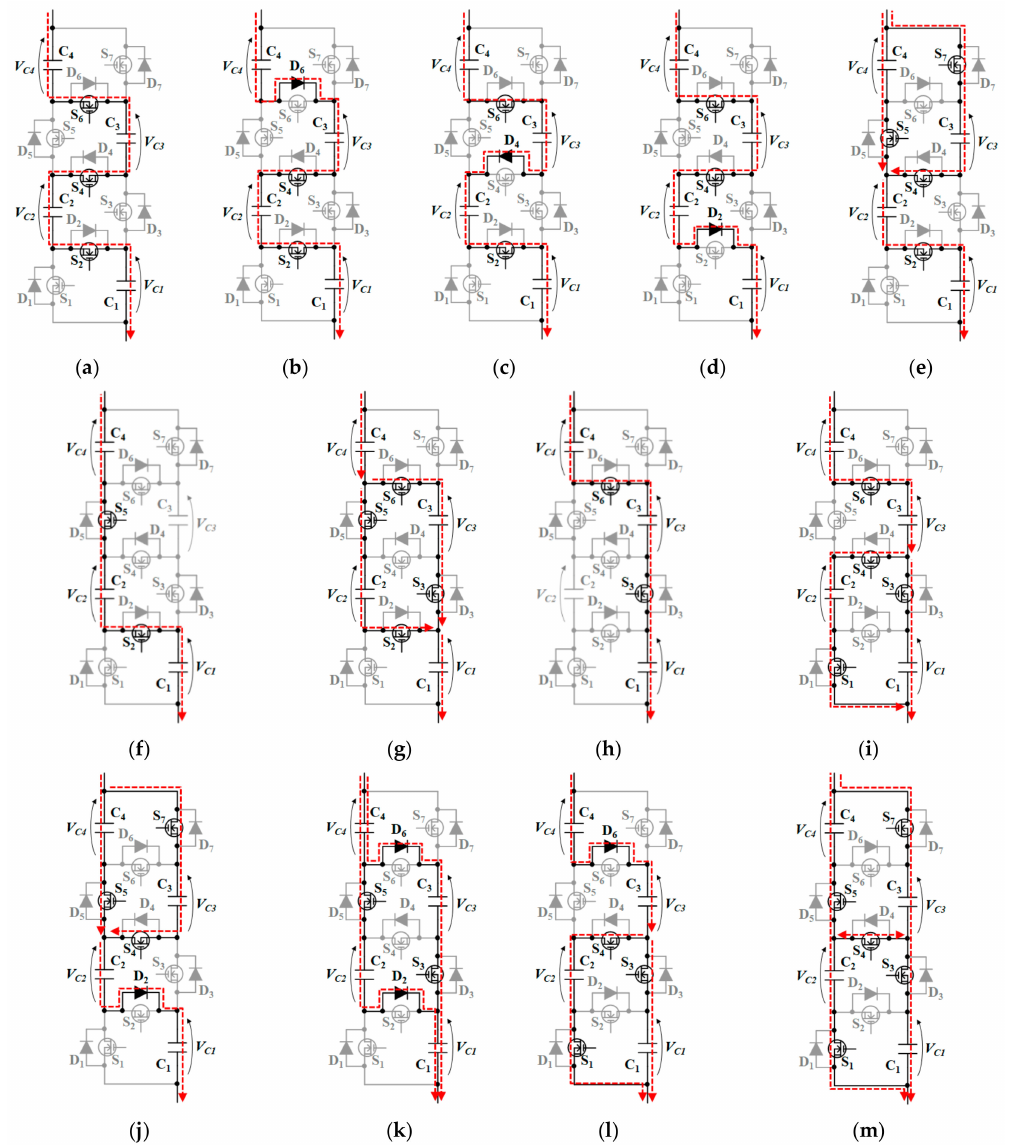
Figure 12. Mode transitions in charging process: current flow paths in ( a ) Mode 3, ( b ) dead time between Mode 3 and sub-Mode A, ( c ) dead time between Mode 3 and sub-Mode B, ( d ) dead time between Mode 3 and sub-Mode C, ( e ) sub-Mode A, ( f ) dead time between sub-Modes A and B, ( g ) sub-Mode B, ( h ) dead time between sub-Modes B and C, ( i ) Mode C, ( j ) dead time between sub-Mode A and Mode 1, ( k ) dead time between sub-Mode B and Mode 1, ( l ) dead time between sub-Mode C, and Mode 1 ( m ) Mode